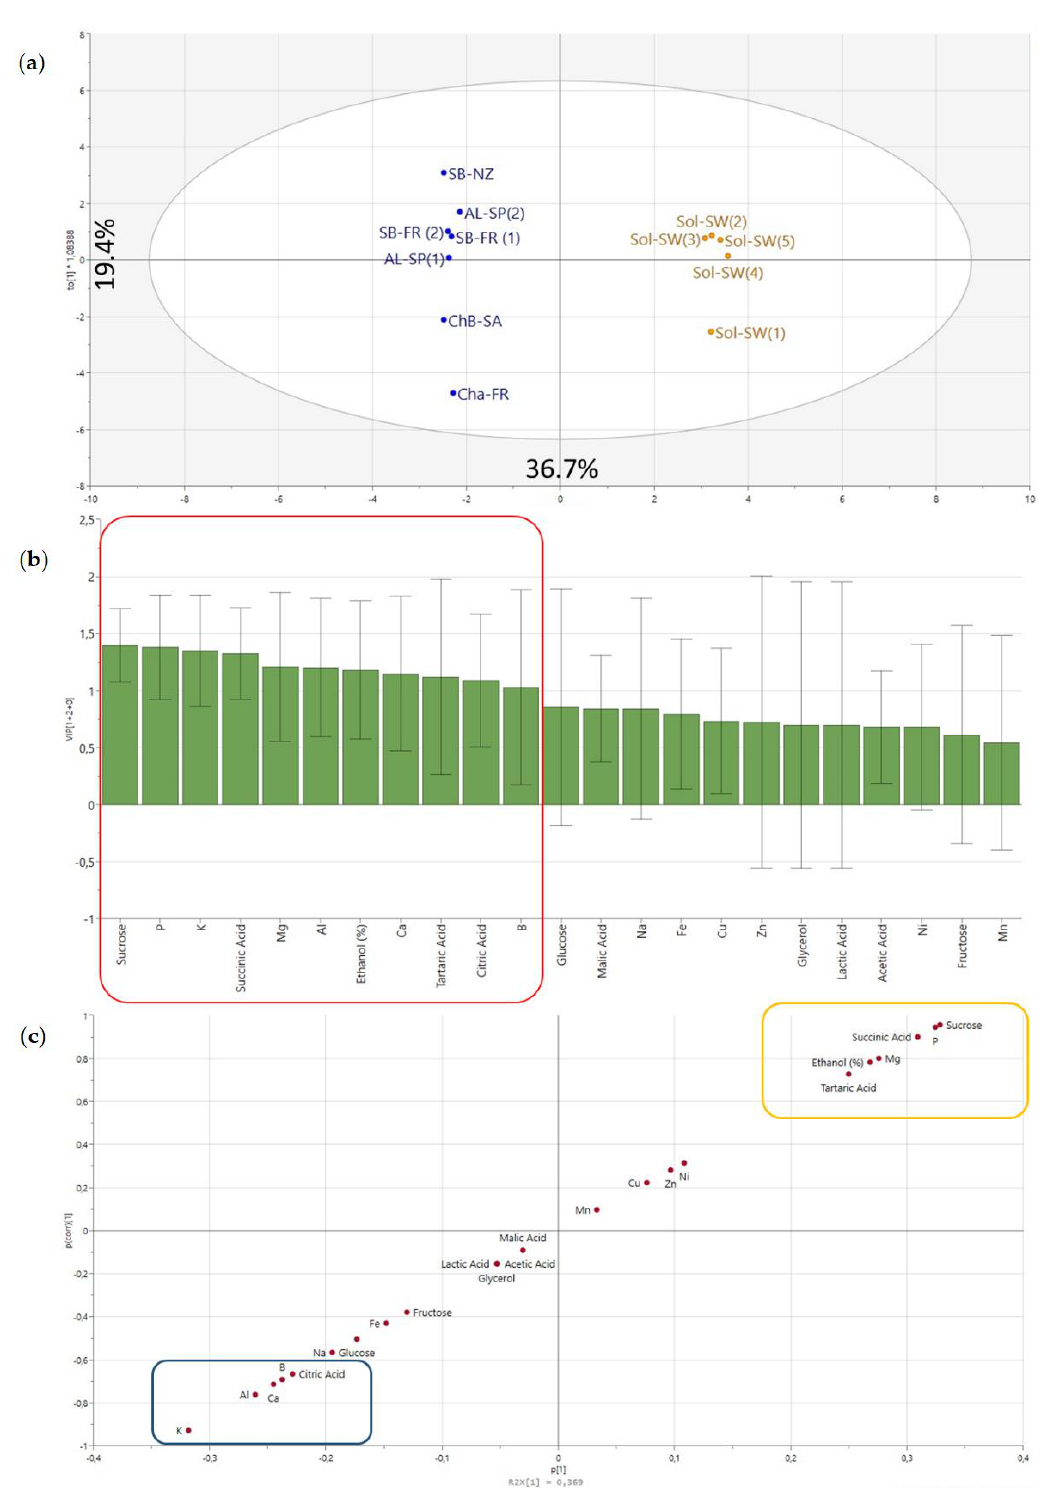
Figure 7. ( a ) OPLS-DA score plot. ( b ) VIP (Variable Importance for Projection). ( c ) S-plot pair wise comparison Solaris (colored in orange) vs. non-Solaris wines (colored in blue) according to the non-volatile composition. Squares on the S-plot represent the significant variables for Sol and non-Sol based on the Student t -Test.